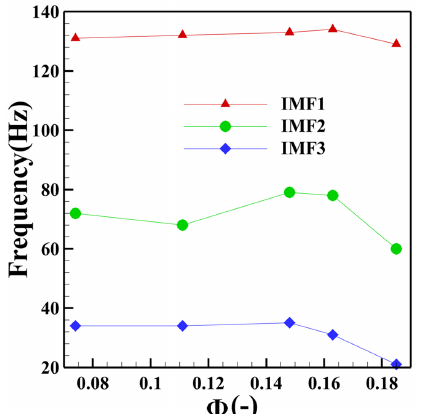
Figure 7. Change of the main frequency of IMF1-3 under operating condition of the MA group.